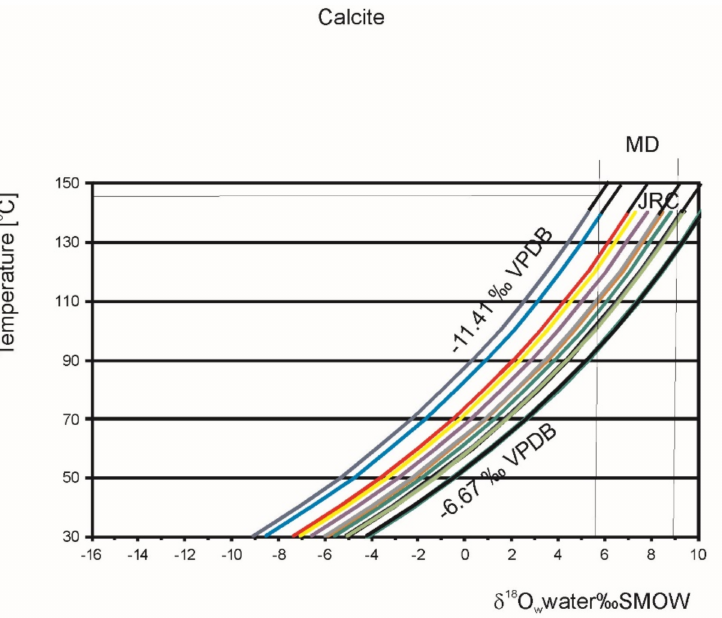
Figure 8. Temperature and δ 18 O relationship for calcite in both regions. Lines were calculated using formula in [38]. MD—range of isotopic values for the MD area; JRC—range of isotopic values for the JRC